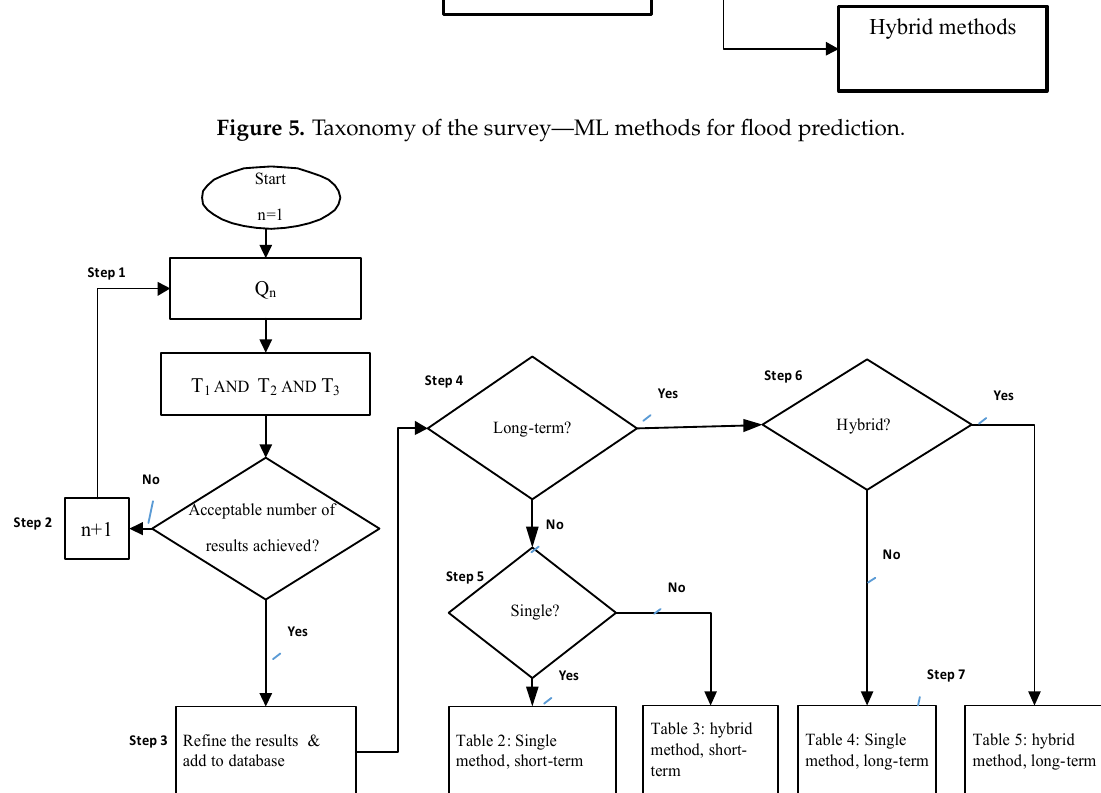
Table 2: Single method, short-term Figure 6. Taxonomy of the survey.